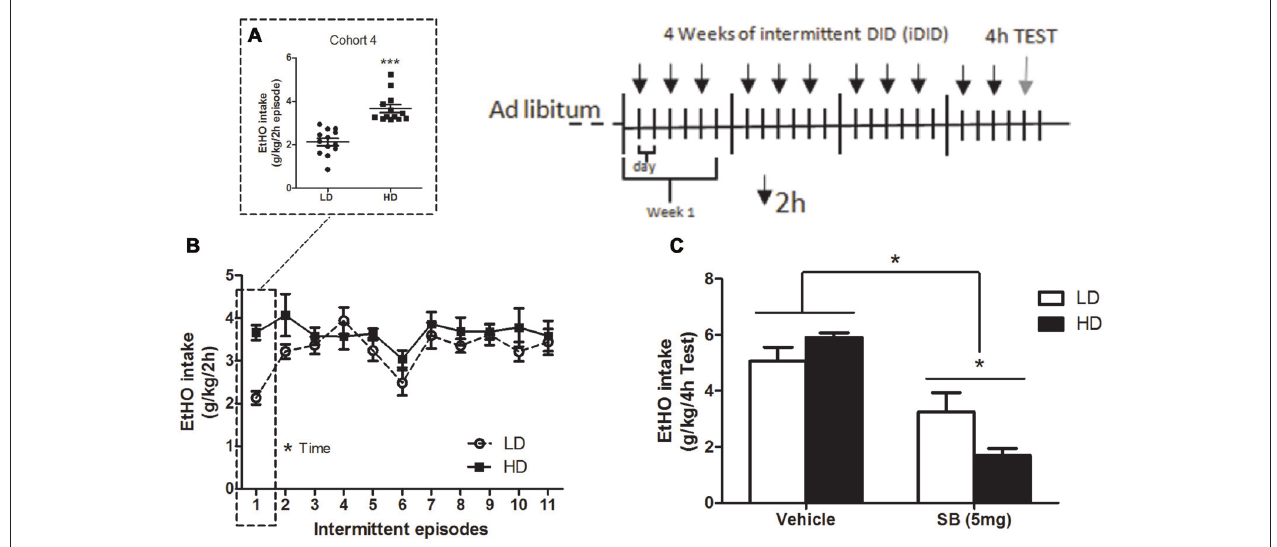
FIGURE 3 | Individual consumption of 20% (v/v) EtOH obtained after a single 2 h DID episode, from which HD/LD subpopulations were identified [Cohort 4] (A) ; consumption of 20% (v/v) EtOH by HD/LD mice during prolonged and intermittent exposure to DID episodes (iDID) (B) ; consumption of 20% (v/v) EtOH by HD/LD subpopulations during a 4 h DID test following ip administration of SB (5 mg/kg) or vehicle (C) . All values are means ± SEM. ∗ p < 0.05 and ∗∗∗ p < 0.001.